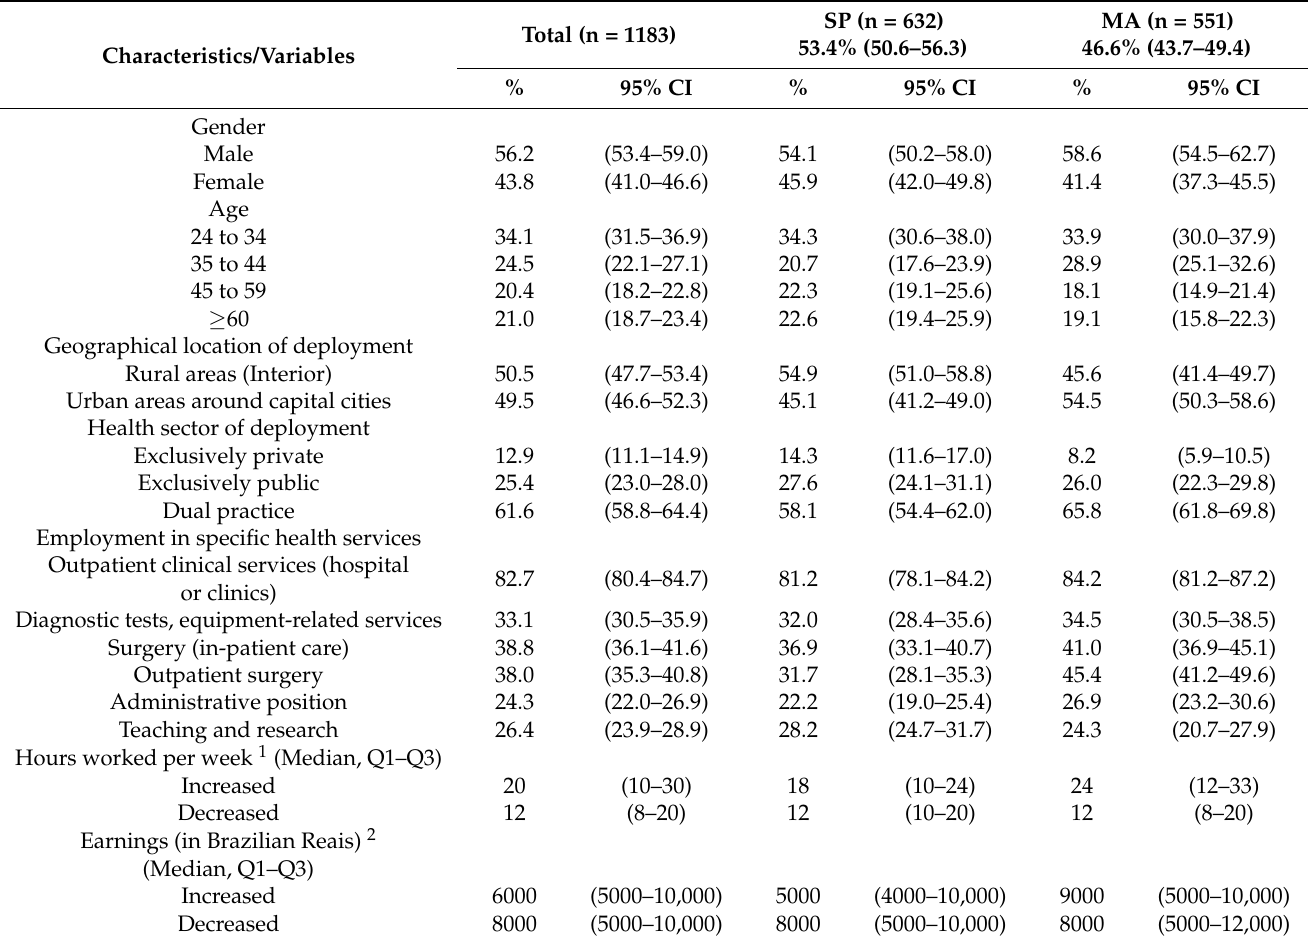
Table 2. Socio-demographic characteristics of physicians interviewed in the Survey on the Labor Market and Impact of the New Coronavirus in SP and MA, Brazil,